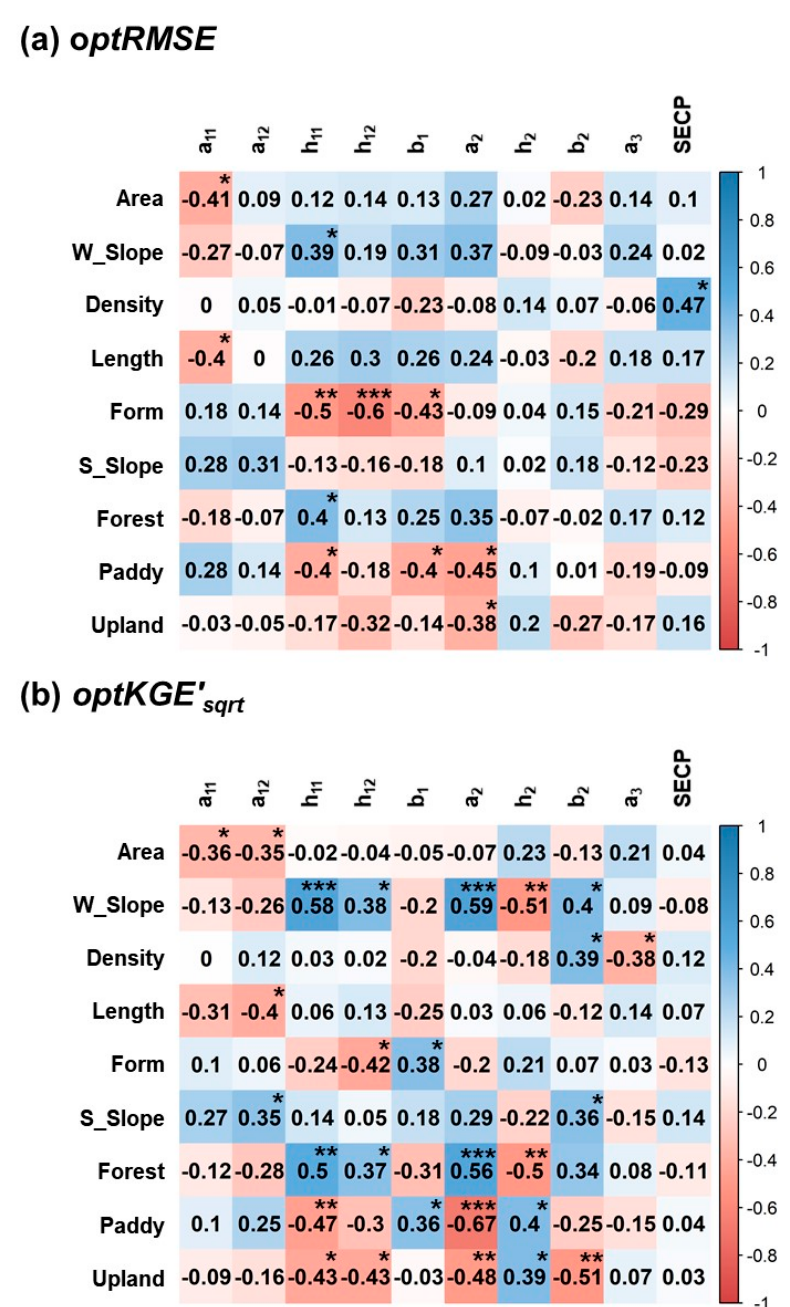
Figure 5. Correlation between calibrated parameter values and selected watershed characteristics. ( a ) optRMSE and ( b ) optKGE (cid:48) sqrt . (*, **, and *** indicate p < 0.05, 0.01, and 0.001, respectively). The parameters of the second tank ( a 2 , h 2 , and b 2 ) and third tank ( a 3 ) determine the shapes of recession and baseflow-only parts of a streamflow hydrograph [8]. The calibrated values of a 2 are relatively strongly correlated to Paddy, regardless of the types of objective functions. In the case of calibrating with KGE (cid:48) sqrt , h 2 was found to be correlated to W_Slope ( r = − 0.51, p < 0.01) or Forest ( r = − 0.50, p < 0.01), and b 2 was also correlated to Upland ( r = − 0.51, p < 0.01). The calibrated values of a 3 were associated with Density ( r = − 0.38, p < 0.05) when KGE (cid:48) sqrt was used as the objective function; however, the parameter did now show any statistically significant relationship with the watershed characteristics in the case of the RMSE objective